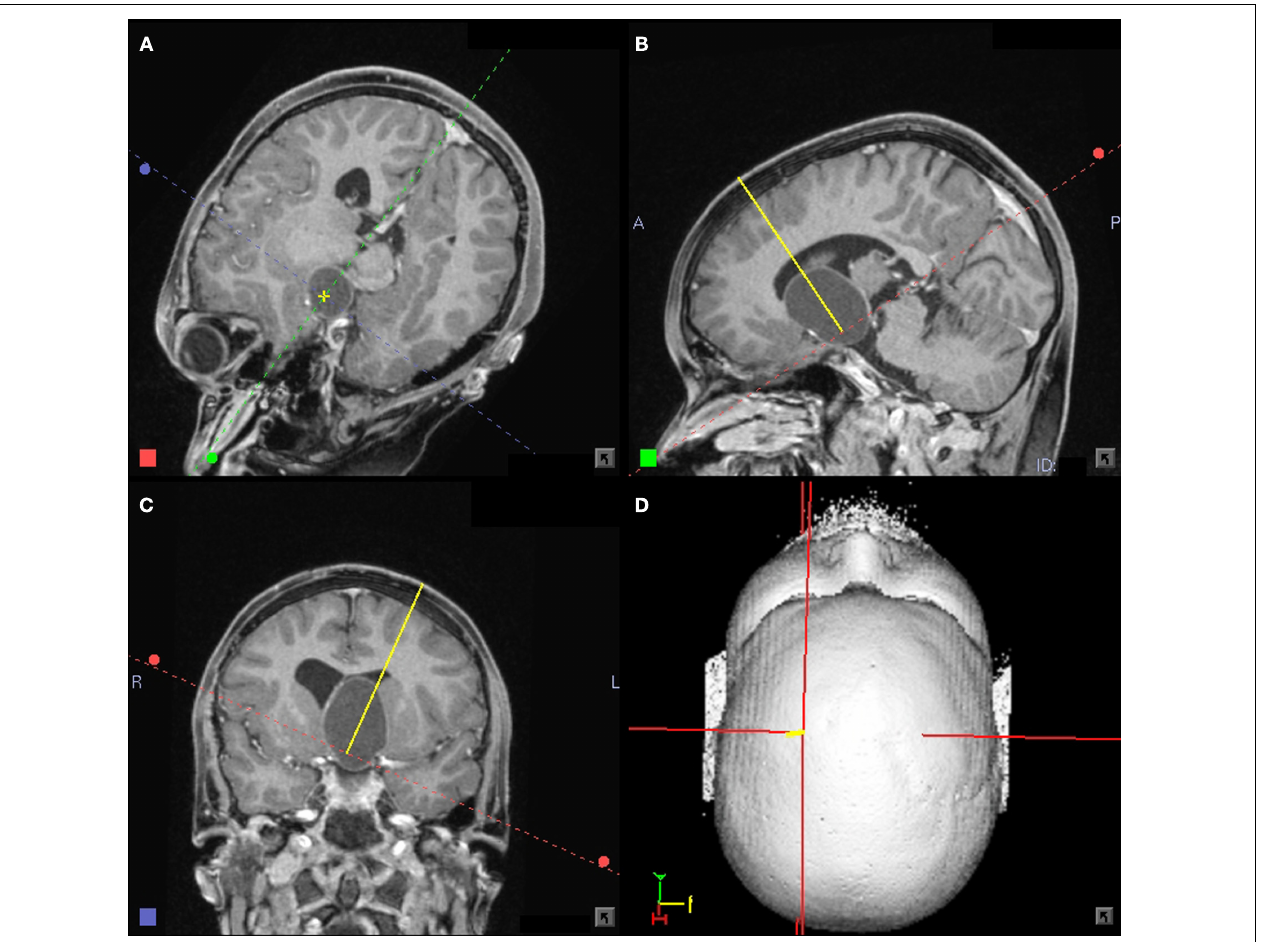
FIGURE 2 | (A–D) Eleven-year-old boy with a large craniopharyngioma cyst. Planning for a stereotactic biopsy and a cyst puncture with subsequent internal drainage showing the trajectory in an approach oriented view. Stereotactic planning system: STP4 – workstation (Stryker-Leibinger, Freiburg, Germany).